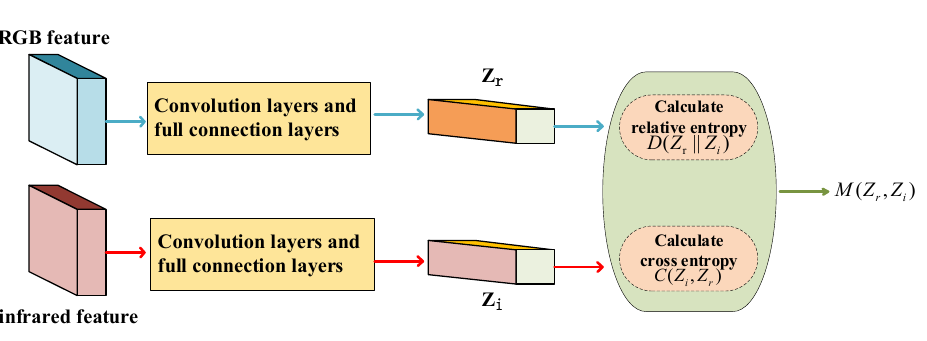
Figure 2. Mutual information